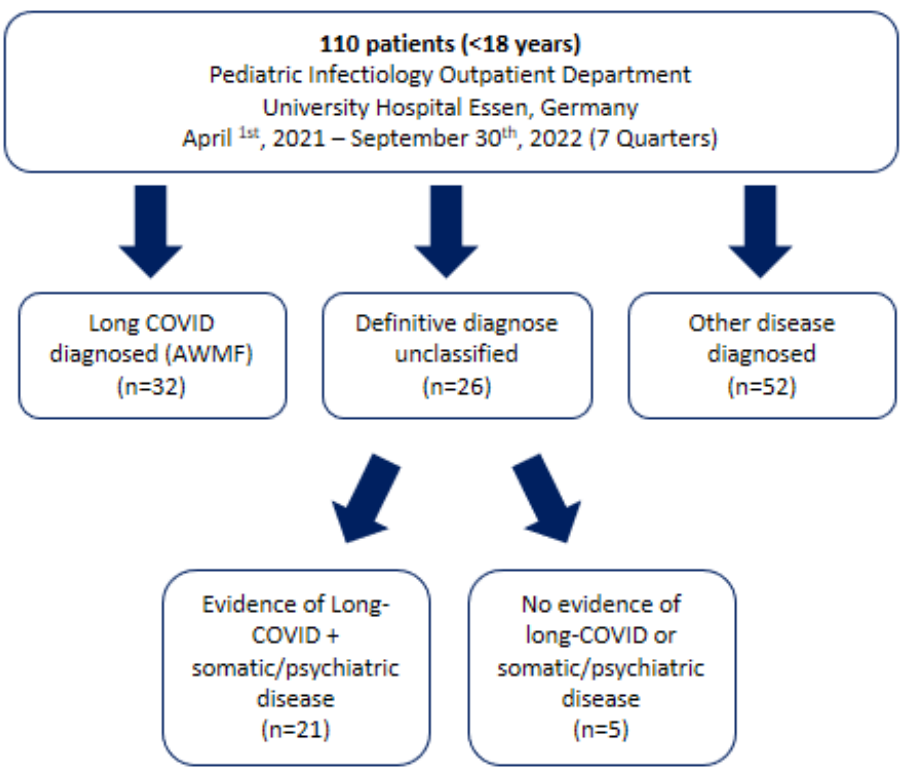
Figure 2. Flow chart of children and adolescents who attended the Long COVID Outpatient Depart- ment at the University Hospital Essen between January 2021 and September 2022 with suspected long COVID.